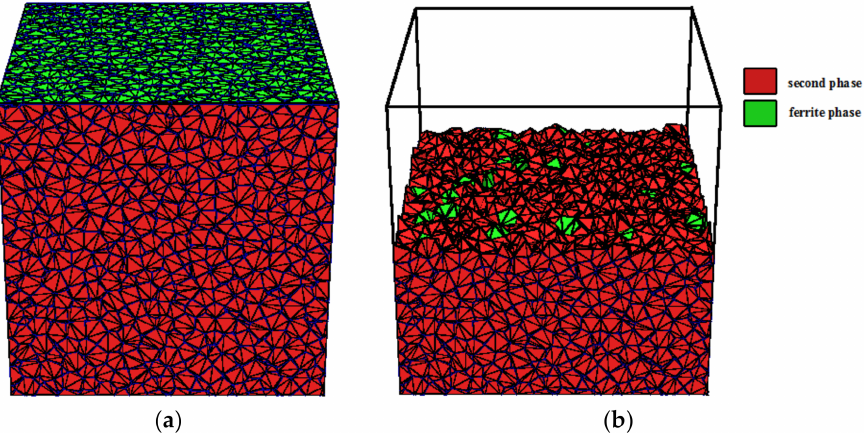
Figure 4. 3D graphs of tetrahedral finite element mesh for a DP steel model: ( a ) the whole tetrahedral finite element mesh; ( b ) a cross-section of the tetrahedral finite element